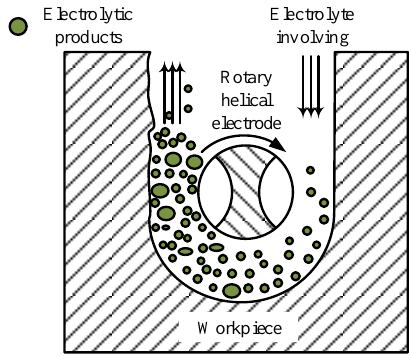
Figure 5. The transfer mechanism of the electrolytic products in the machining gap.